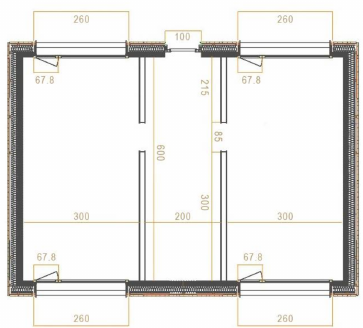
Figure 1. Architectural section of the modular standard double-office used for the simulations [32].